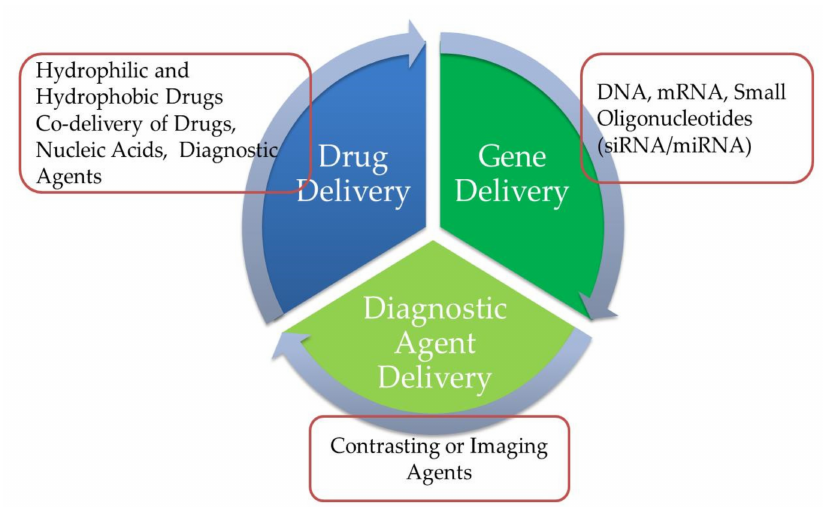
Figure 10. Diagram depicting the biopharmaceutical applicability of polymer–lipid hybrid nanopar- ticles